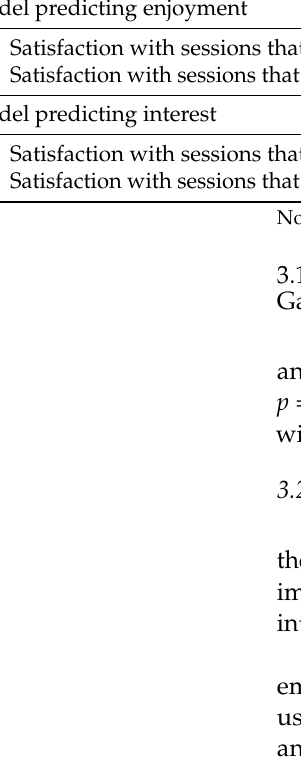
Table 1. Model summary for regression analyses using satisfaction with sessions that did and did not use serious games as independent variables and enjoying activities and interest in subjects as dependent variables, respectively (N = 57). R 2 Adjusted R 2